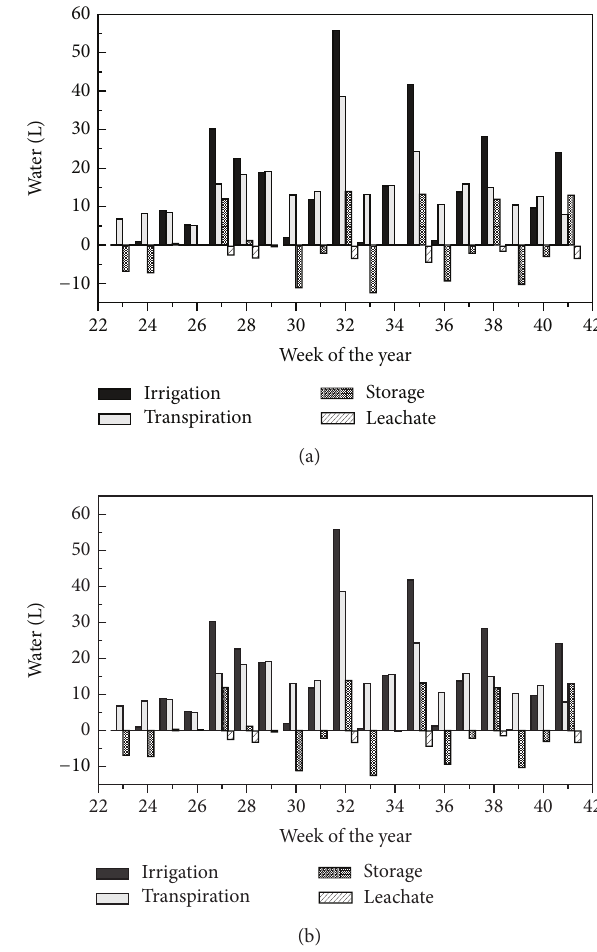
Figure 3: Mean of the daily temperature and relative humidity measured on a hourly basis, calculated from 09:00 HR to 18:00 HR, recorded throughout the vegetation period.